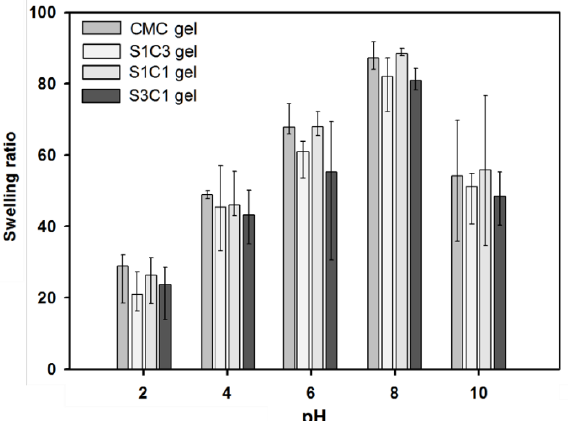
Figure 8. The influence of different pH conditions (pH 2, 4, 6, 8, and 10) on the equilibrium swelling ratio of SG, CMC gel, and SG/CMC IPN hydrogel at 37 °C.